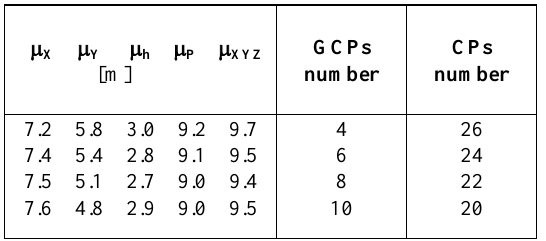
Table 5. Statistics of location accuracies with different number of GCPs in Xinjiang field